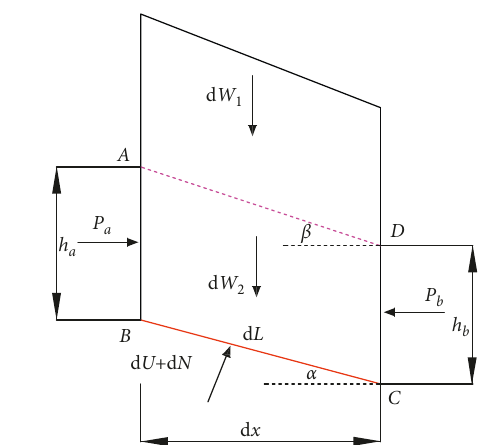
Figure 3: Forces acting on the slices subjected to seepage loads when the slice forces are